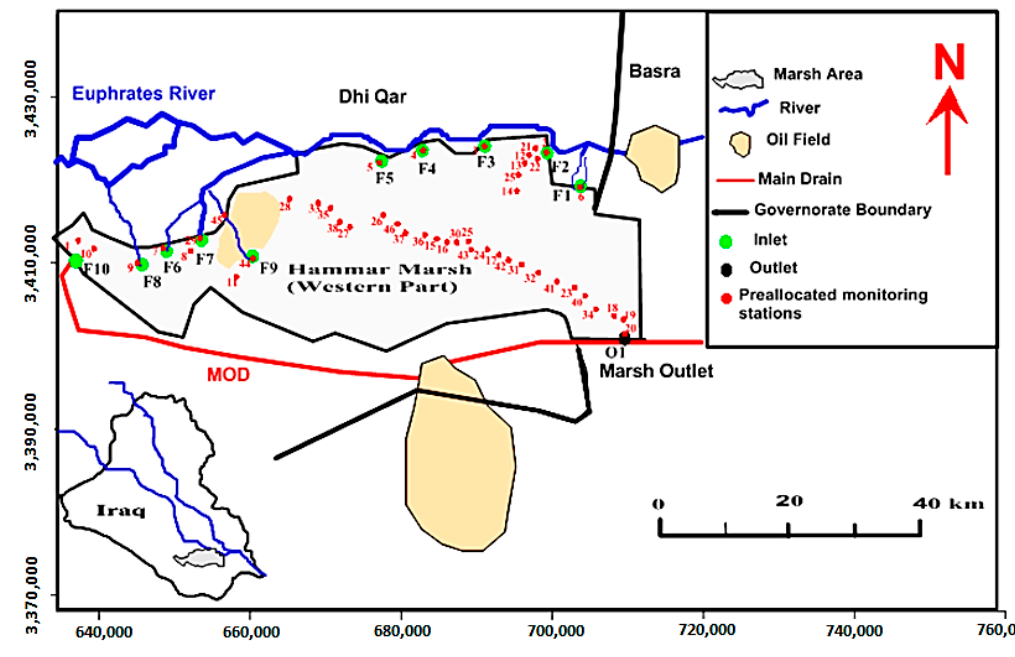
Figure 1. Layout of the Al-Hammar Marsh.